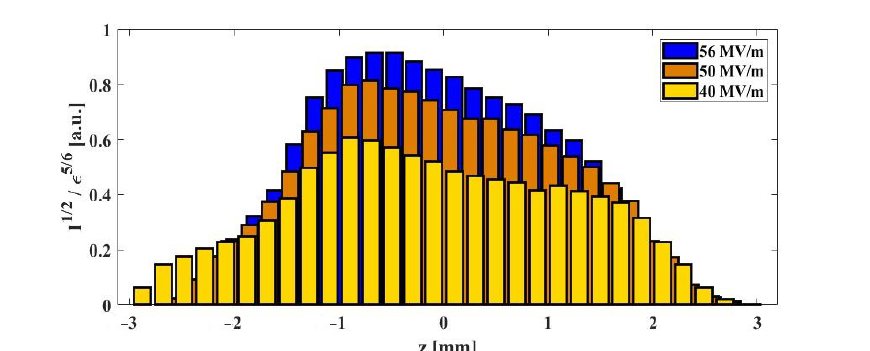
Figure 6. Evaluation of sliced gain parameters accounting for slice current and slice emittance along the optimized bunches which is of more relevance to the FEL